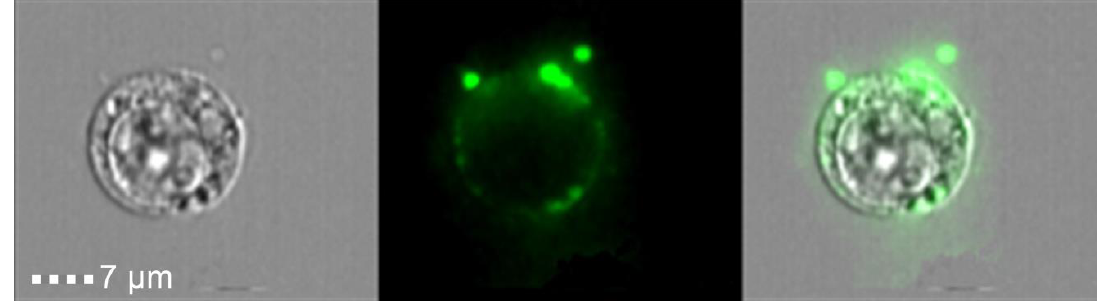
FIGURE 1: Phosphatidylserine exposure on necroptotic cells and ‘necroptotic bodies’ prior to outer plasma membrane permeabilization. U937 cells were stimulated for necroptosis by addition of TNFα (20 ng/ml), SMAC mimetic (20 µM) and zVAD (10 µg/ml). Four hours after stimulation cells were triple stained with Annexin-V-FITC (Green), Zombie (Purple) and PI (Red), and then analyzed by imagestream flow